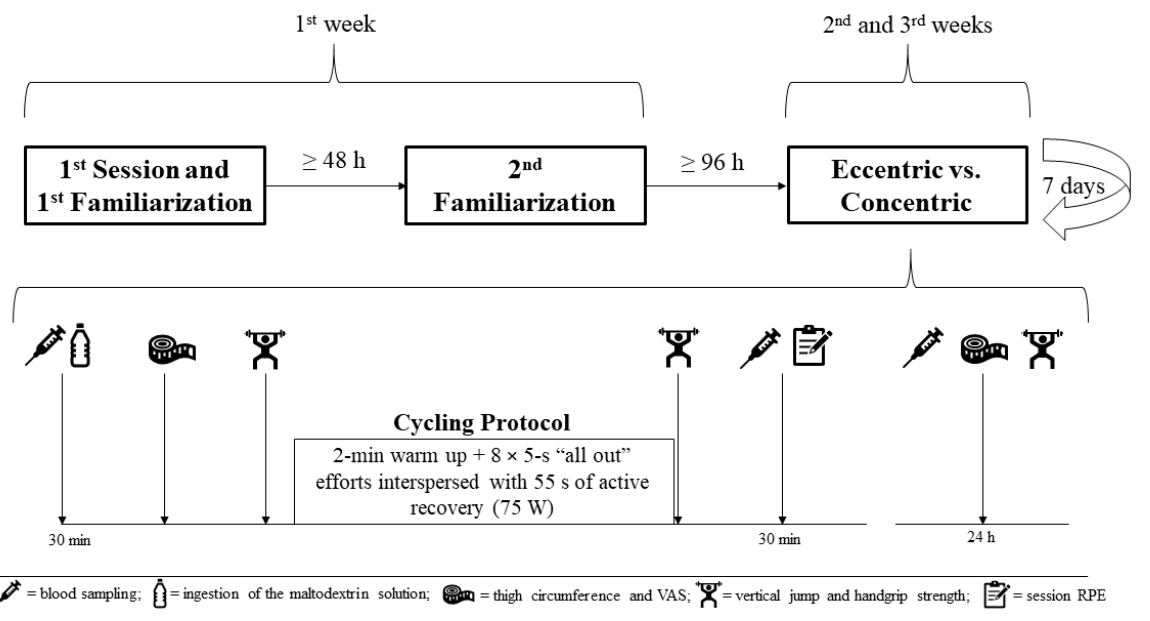
Figure 1. Study design.